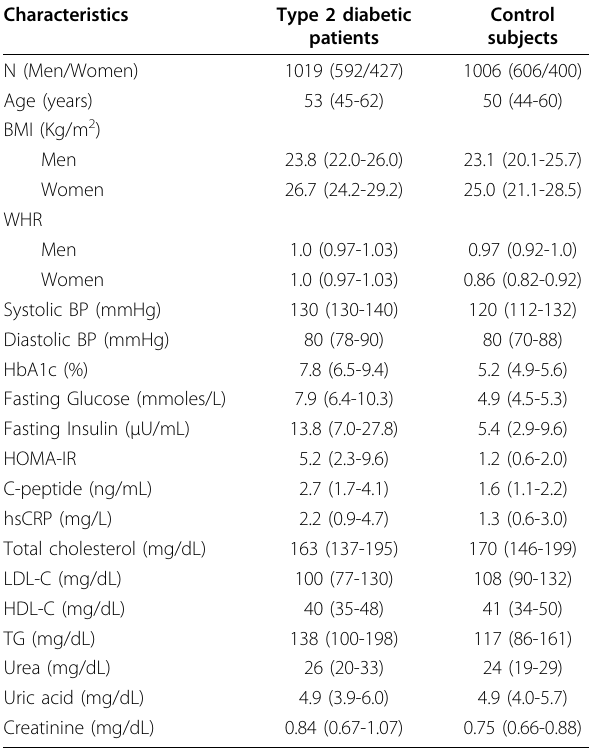
Table 1 Anthropometric and clinical characteristics of the study population